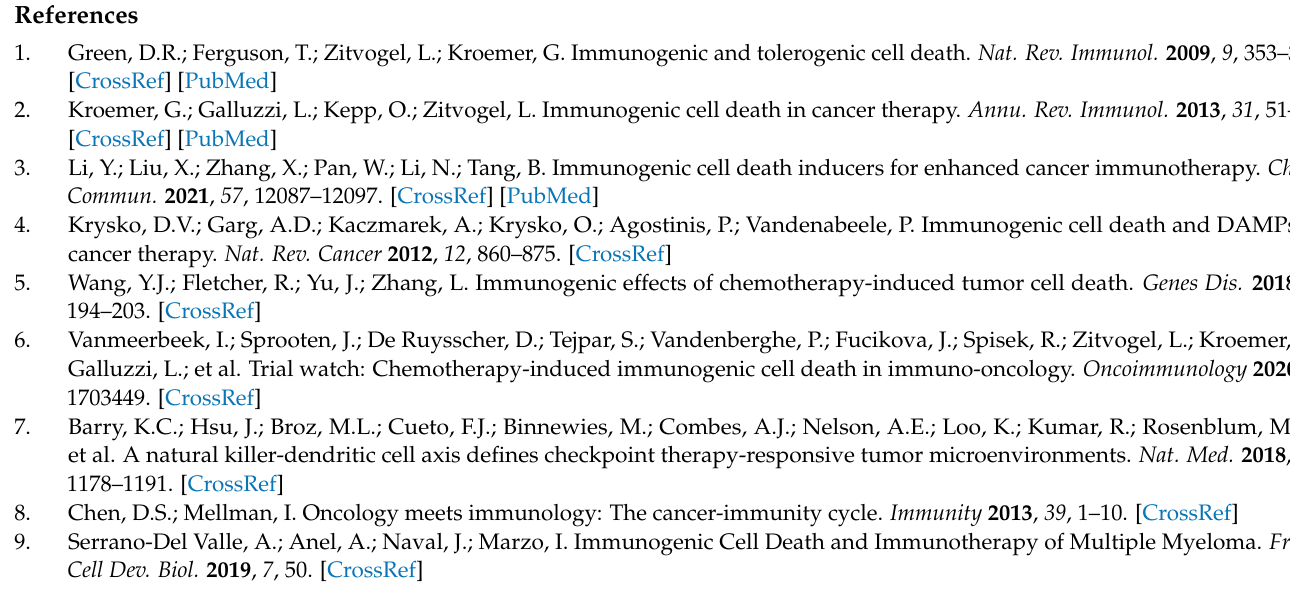
Figure S1: Individual images of Figure 2A. Blue: DAPI; Red: DOX; Green: PLGA. The scale bar indicates 50 µ m, Figure S2: Time schedule of the whole treatment processes for CT26 tu- mor in BALB/c mice, Figure S3: Tumor growth for individual mice and CR rate in PBS-, DP-NPs (5, 10 mg/kg)-, and aPD-L1 Ab (10 × 5 mg/kg)-combined DOX-HCl (10 mg/kg)-treated groups of Figure 4A, Figure S4: Representative images of H&E-stained tissues (liver, lung, kidney, and heart) at 14 days after the first treatment of PBS, P-NPs, DOX-HCl (10 mg/kg), DP-NPs (5, 10, 10 × 2 mg/kg). The scale bar indicates 250 µ